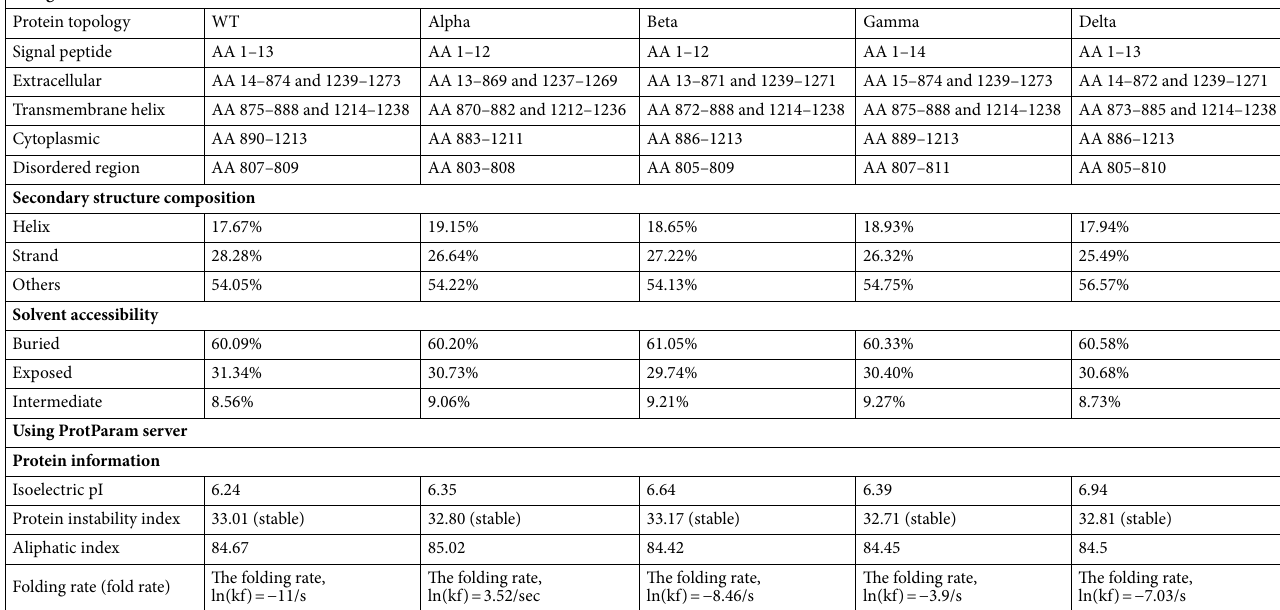
Table 3. Effect of the point mutations on the topology, structure and conformation of the wild-type and mutant spike